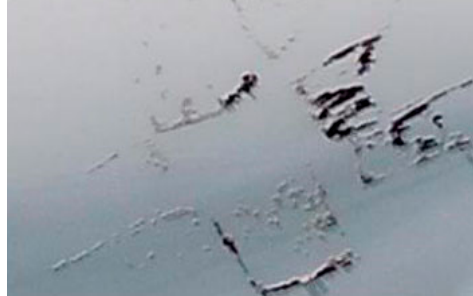
Figure 5. An image of the region of interest.